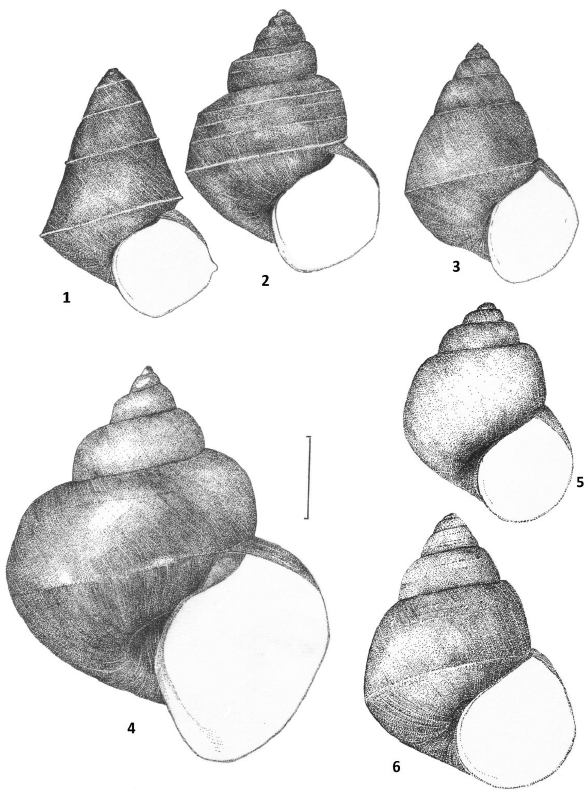
Fig. 2. Example of partly repeated convergent evolution in the Malawi Basin. Two groups of endemic lacustrine Bellamya species (Viviparidae) that evolved in lakes of the Malawi basin separated by ca. 2 million years. The first group, consisting of (1) B . cf. pagod- iformis , (2) B . cf. trochlearis , and (3) B . cf. robertsoni, lived in paleo-lake Chiwondo during late Pliocene–early Pleistocene times. The second group, consisting of (4) Bellamya ecclesi , (5) B. jeffreysi and (6) B. robertsoni , occurs in present Lake Malawi. Both groups are not directly affiliated (Scale bar: